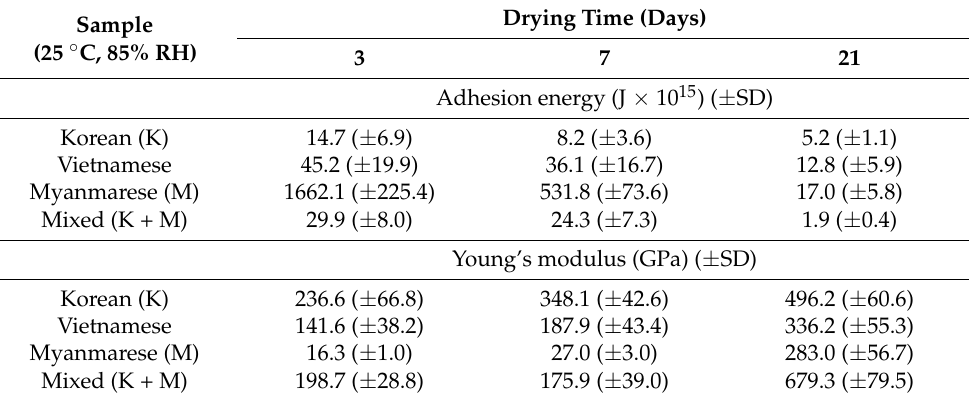
Figure 4. Force–distance curve measurements by AFM for Oriental lacquer films after a drying time of 14 d. Table 6. Force–distance curve measurements by AFM for Oriental lacquer films as a function of drying